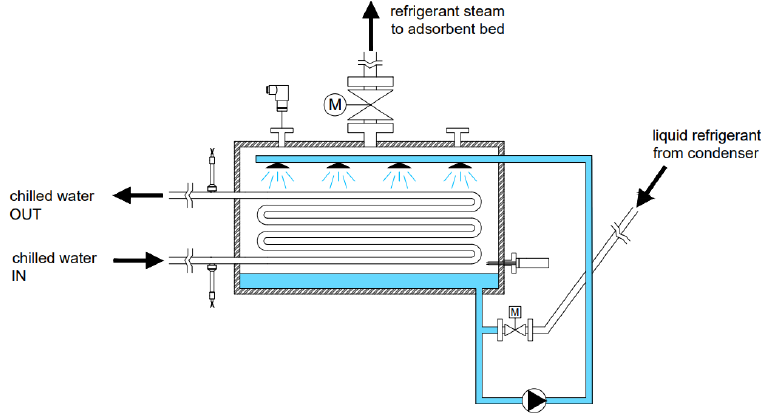
Figure 1. Photo ( a ) and functional scheme ( b ) of the test rig.